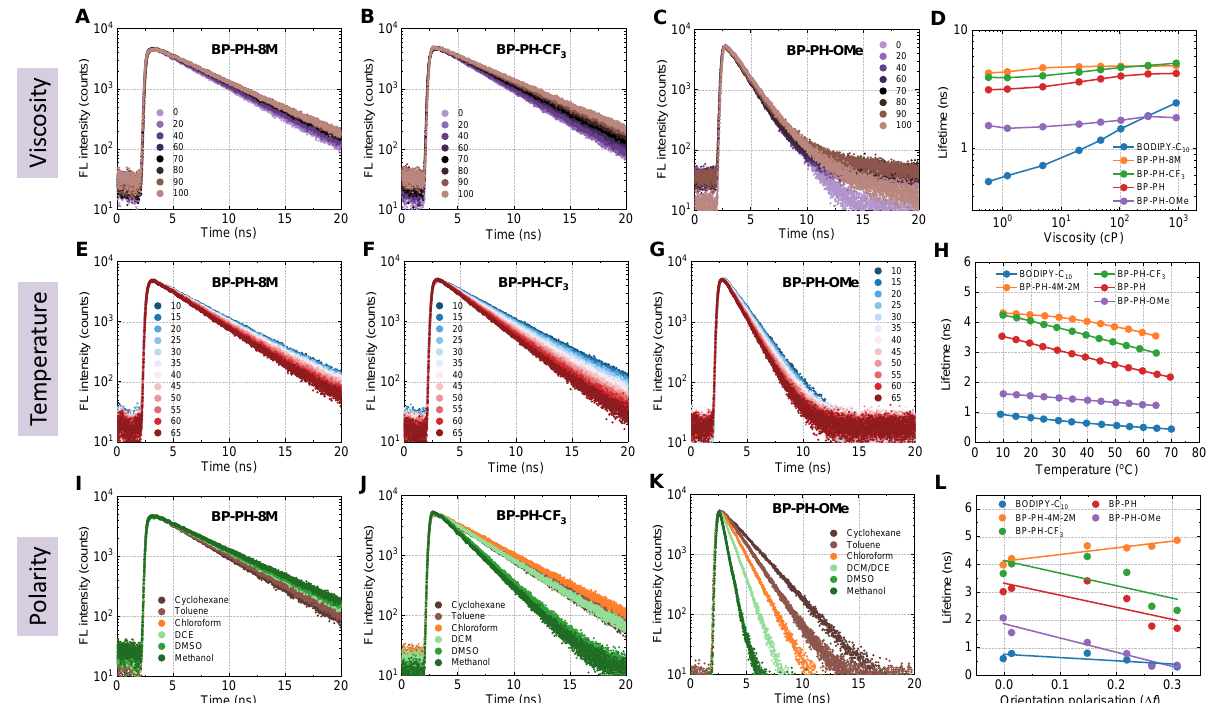
Figure 4. Time-resolved fluorescence decays of BP-PH-8M, BP-PH-CF 3 , BP-PH-OMe, and their sensitivity to viscosity, temperature, and polarity. ( A – D ) Viscosity dependence in toluene-castor oil mixtures. ( E – H ) Temperature dependence obtained in toluene. ( I – L ) Polarity dependence in different polarity solvents. The polarity of solvents is quantified using their orientational polarizability. The data for BP-PH and BODIPY-C 10 is provided for comparison in ( D , H , L